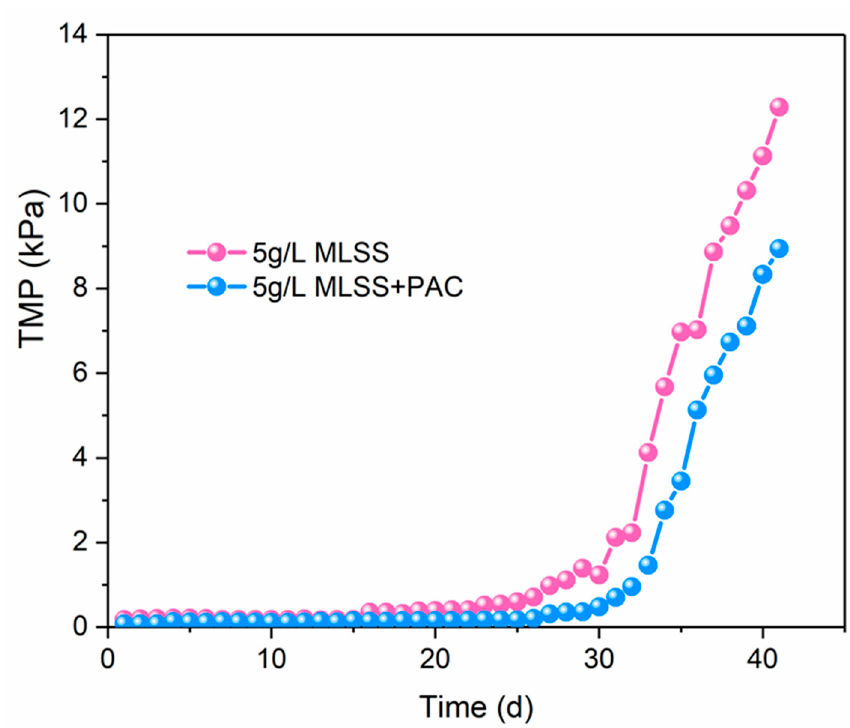
Figure 3. TMP profile at constant flux during operation in C-DMBR and PAC-DMBR. Membranes 2020 , 10 , x FOR PEER REVIEW